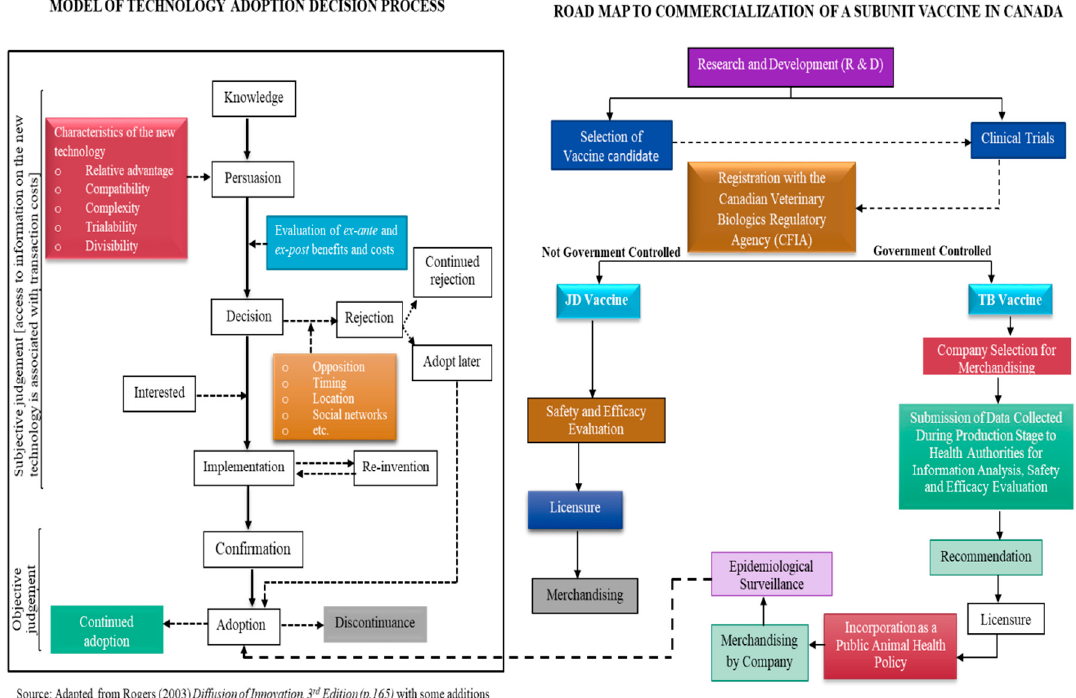
Figure 4. Road map to commercialization of subunit vaccines for JD and bTB (Canadian example). Source: Authors’ construction.